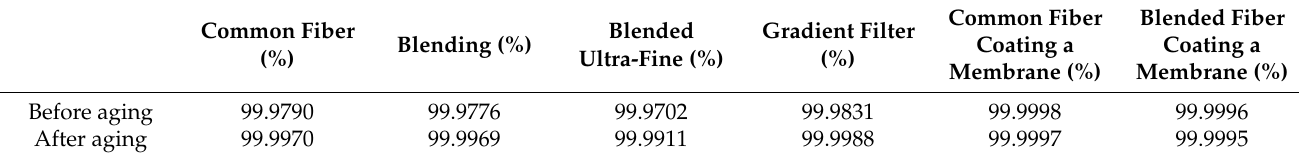
Table 6. Filtration efficiency of different formula